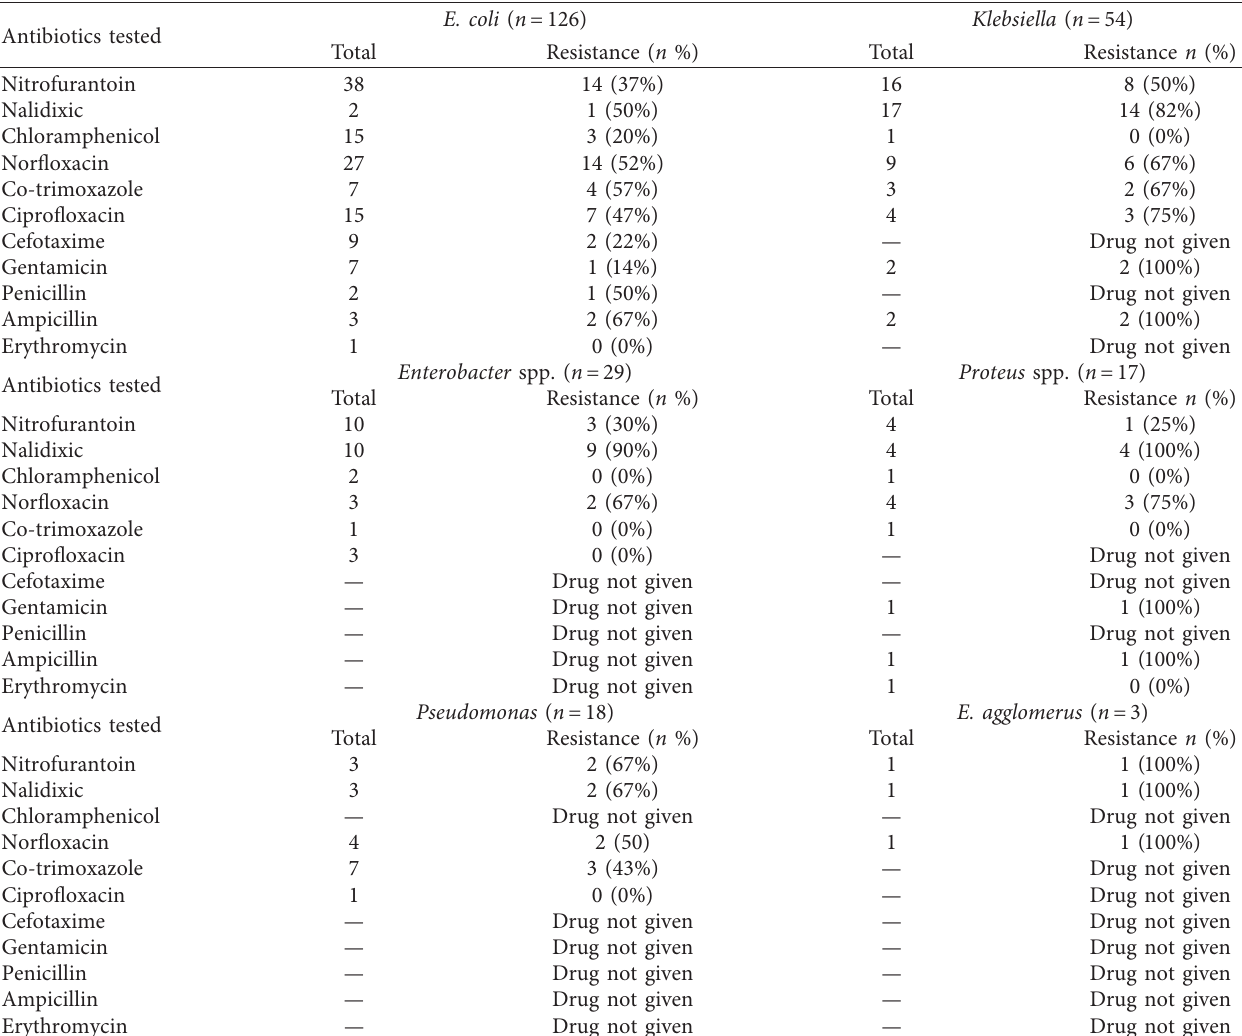
Table 3: Susceptibility patterns of Gram-negative isolates.